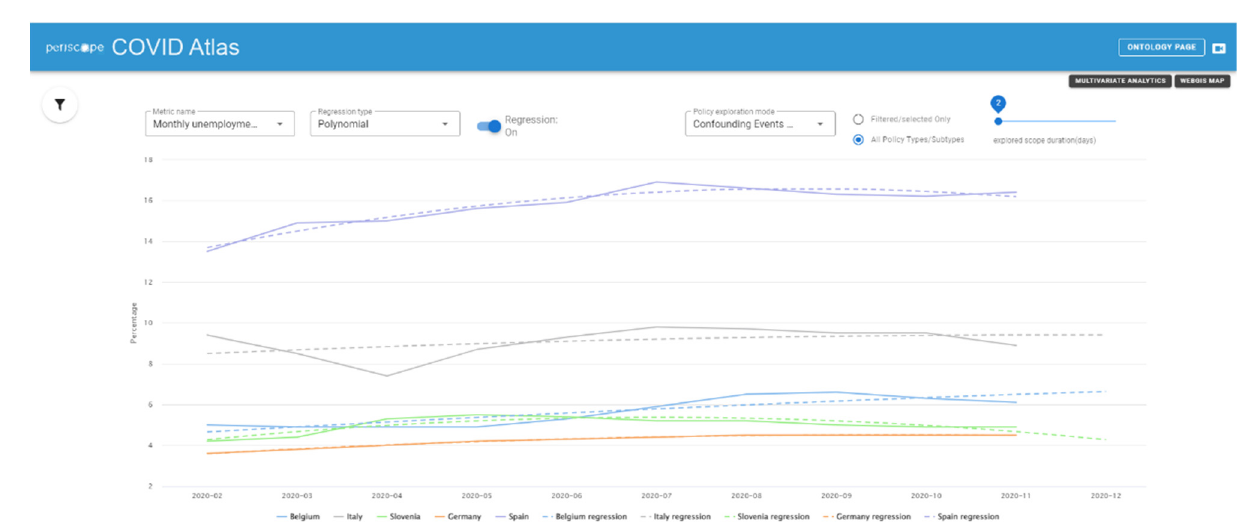
Figure 8. Example of the visualization in the Temporal Analytics page of the Atlas.